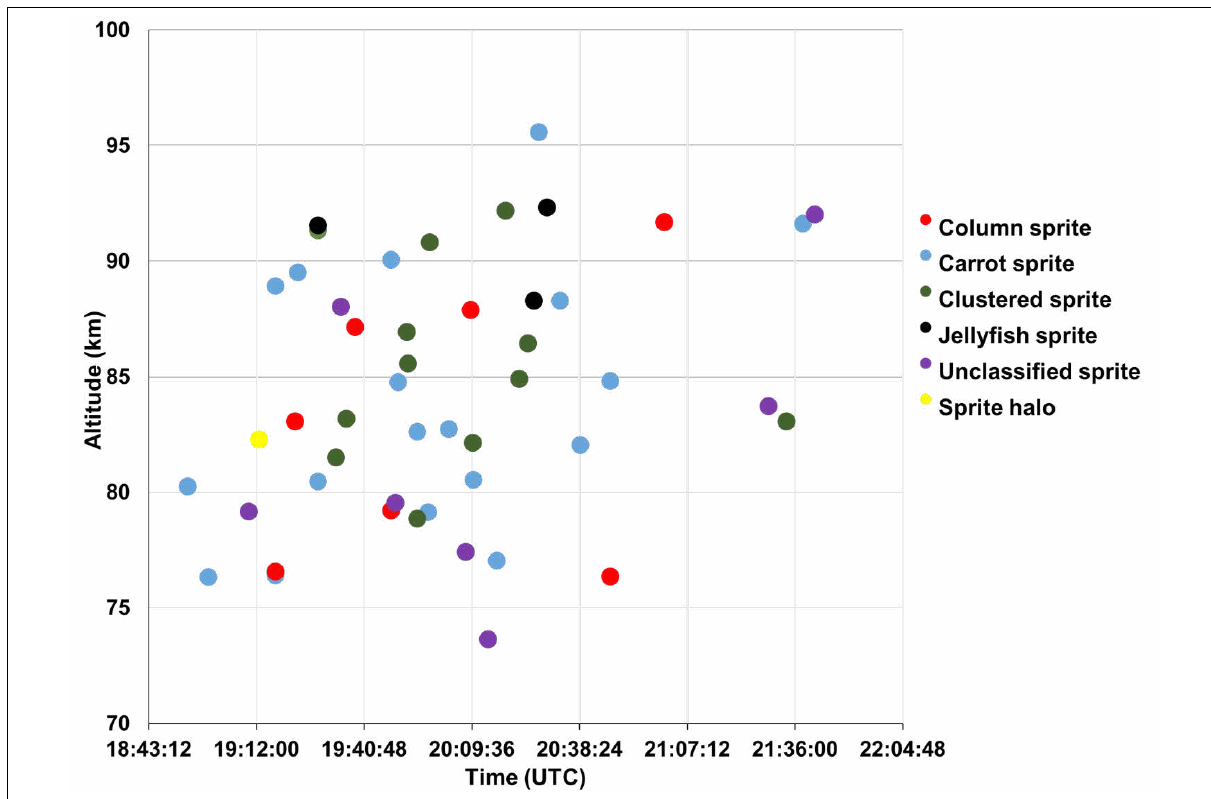
Figure 3: The top altitude of the 48 sprites with respect to the time at which they were observed during the 2016 sprites campaign.